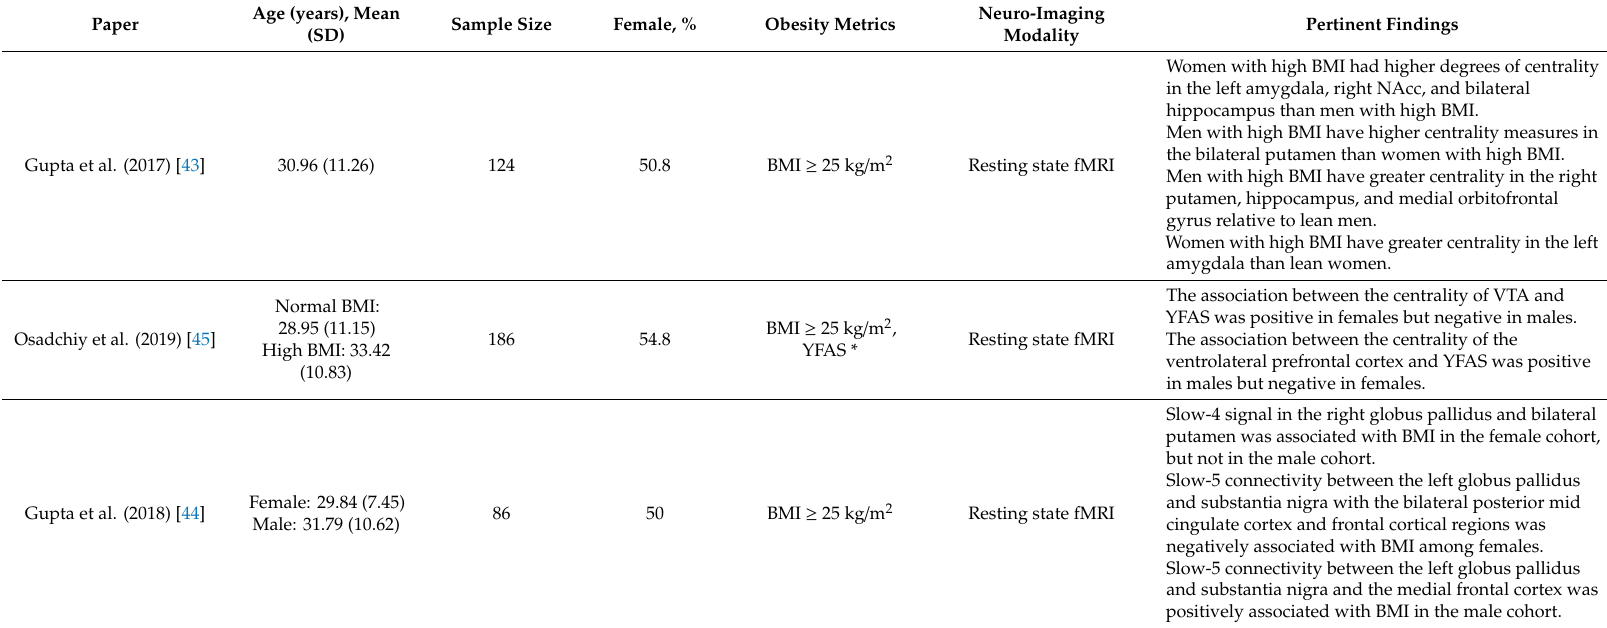
Table 2. Brain resting-state study sample characteristics and